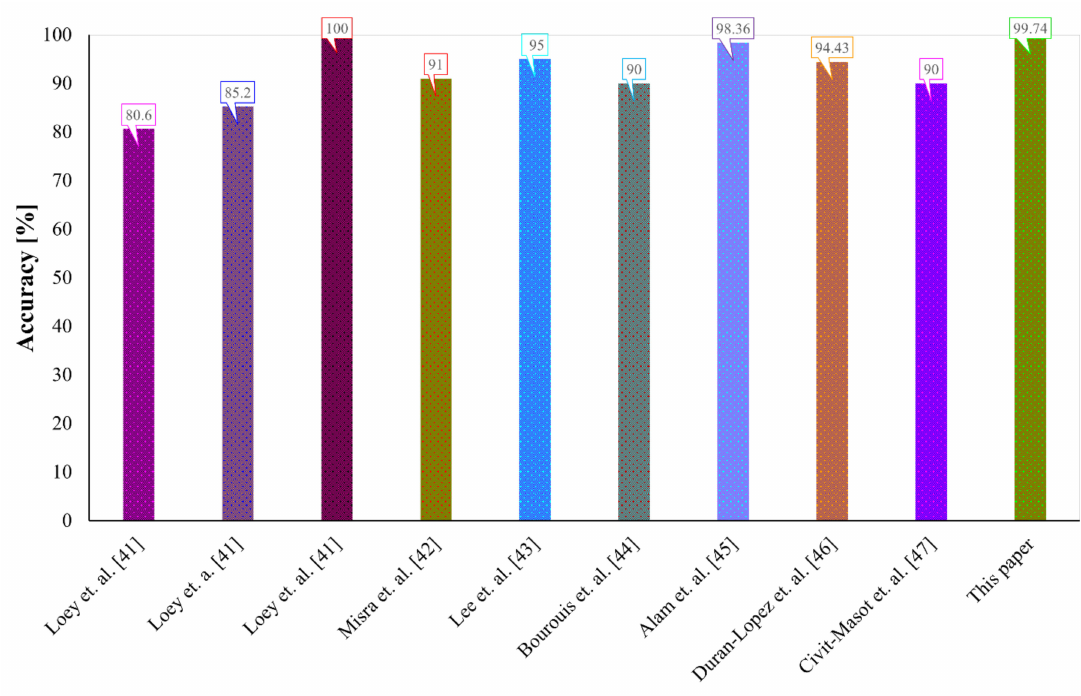
Figure 10. Comparison of the first-stage accuracy of the proposed method with others using chest X-rays.